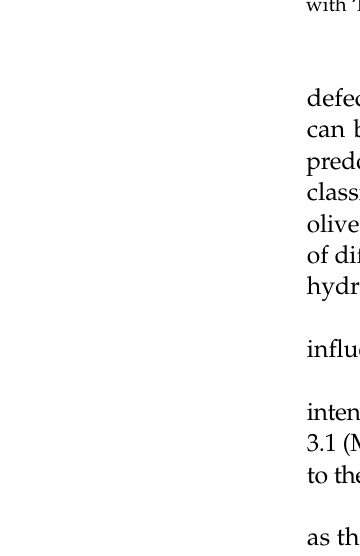
C: Spanish-style green table olives without aroma; M2: Spanish-style green table olives with ‘Mojo pic ó n’ aroma at 2%; M4: Spanish-style green table olives with ‘Mojo pic ó n’ aroma at 4%; M8: Spanish-style green table olives with ‘Mojo pic ó n’ aroma at 8%. n.d.: not